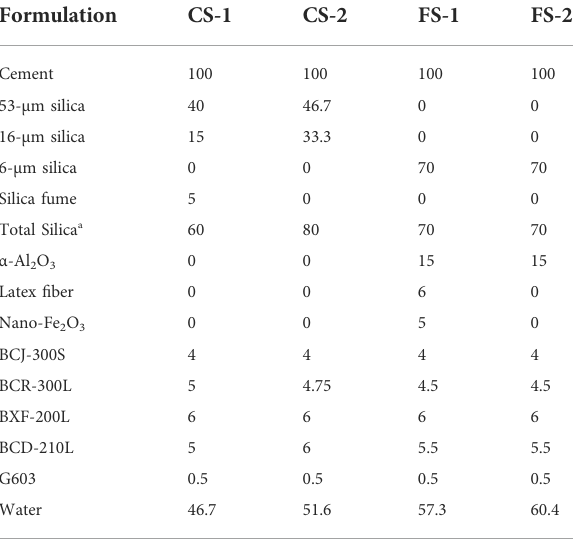
TABLE 1 Slurry composition designs (based on the weight of